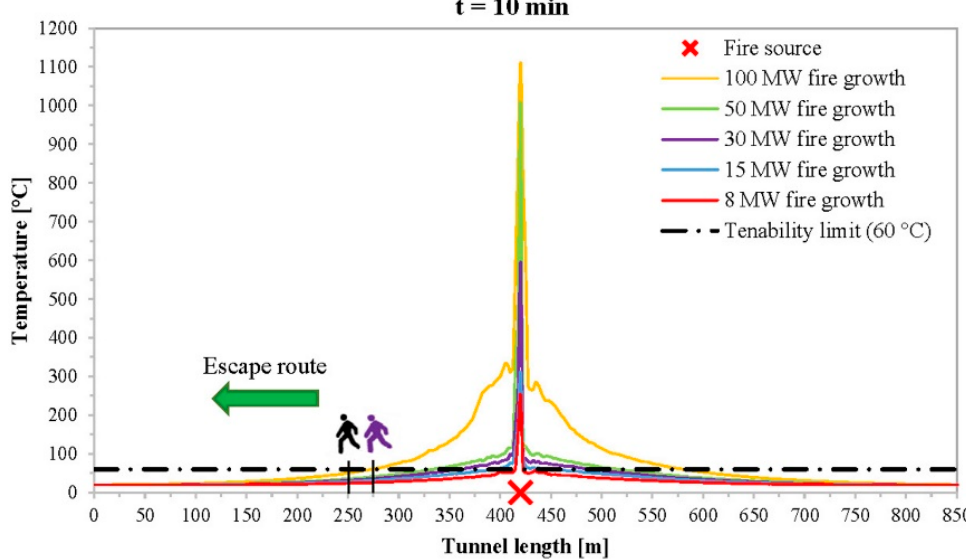
Figure 6. Profiles of longitudinal temperature at a height of 2 m along the escape route on the road carriageway after 10 min from the fire’s start when the burning vehicle is at 420 m from portal A.